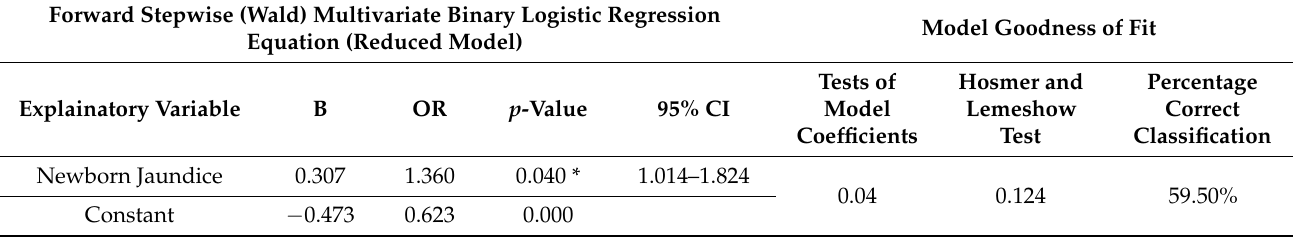
Table 5. Stepwise (Wald) Multivariate Binary logistic regression of etiological factors for MIH. Forward Stepwise (Wald) Multivariate Binary Logistic